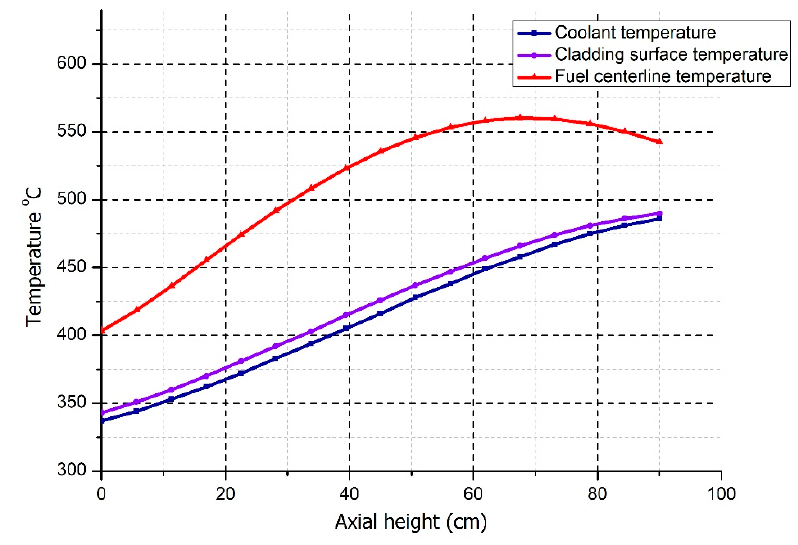
Figure 8. Axial temperature profile of the hottest assembly at BOC.